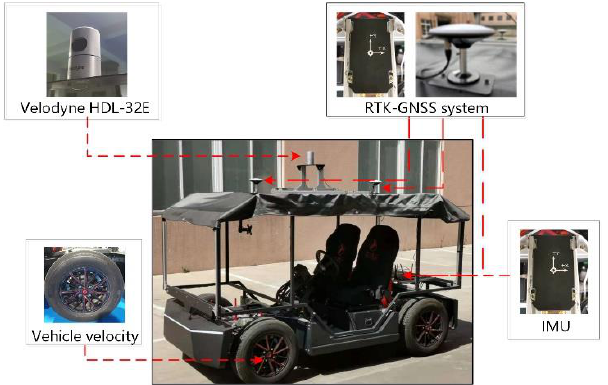
Figure 11. Test vehicle and sensors configuration. Table 3. Sensor specifications of test vehicle (Velodyne HDL-32E from Velodyne, San Jose, CA, USA.